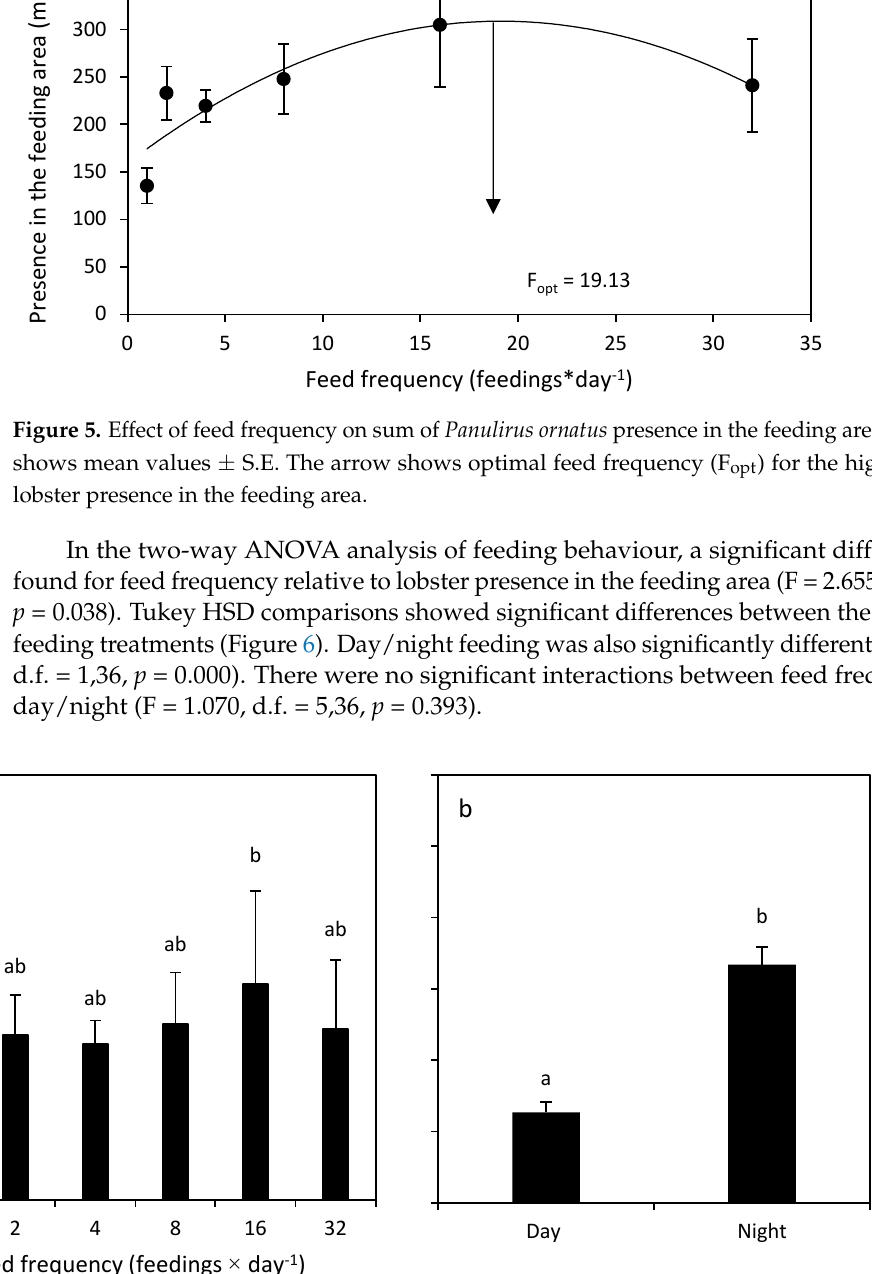
Figure 6. ( a ) Effect of feed frequency and ( b ) daytime on Panulirus ornatus presence in the feeding area (min*head − 1 ). The graphs show mean values ± S.E., and significant differences (ANOVA) are indicated with superscripts.